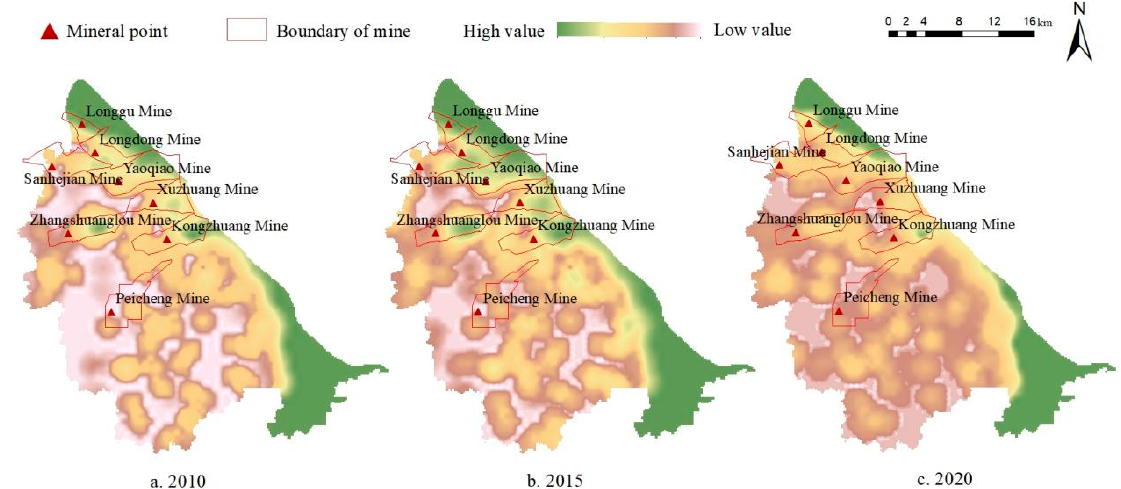
Figure 3. Spatial distribution of ESV in 2010, 2015, and 2020.